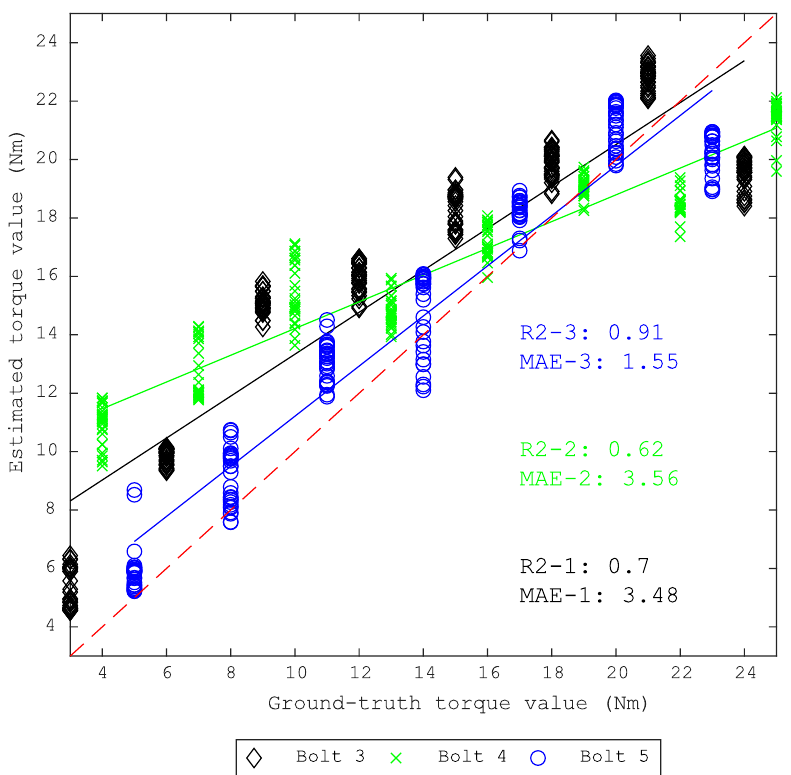
Figure 19. Estimated looseness using trained models on the D4 data set from bolts 3, 4 and 5.